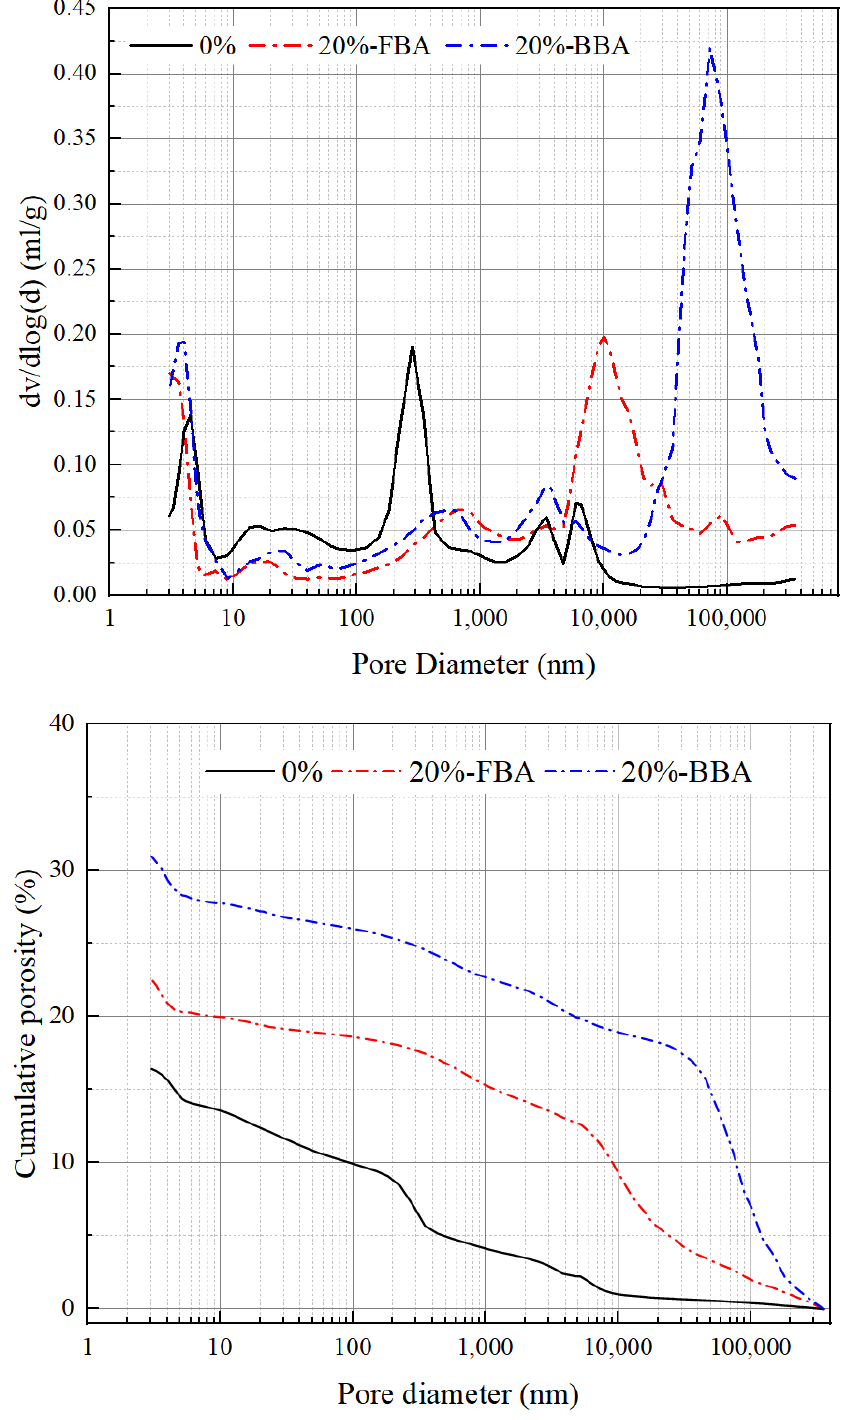
Figure 15. The results of pore structure of MPC mortars with or without BA at 28 days by MIP.